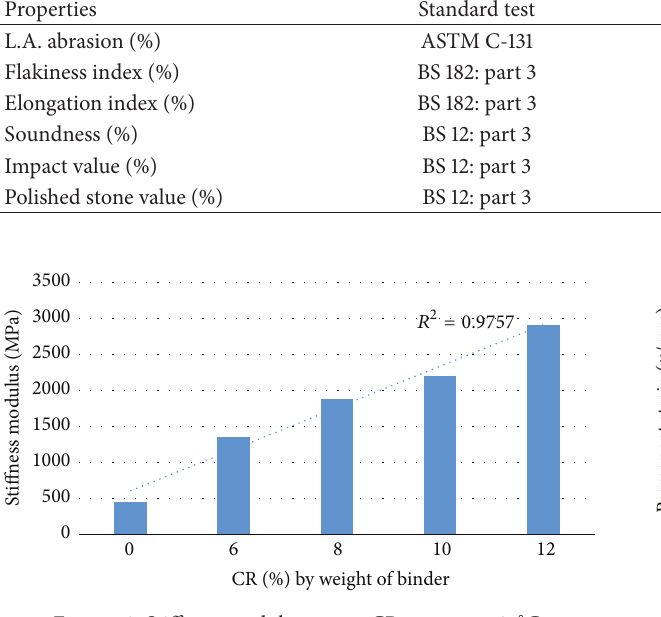
Figure 2: Stiffness modulus versus CR content at 25 ∘ C.